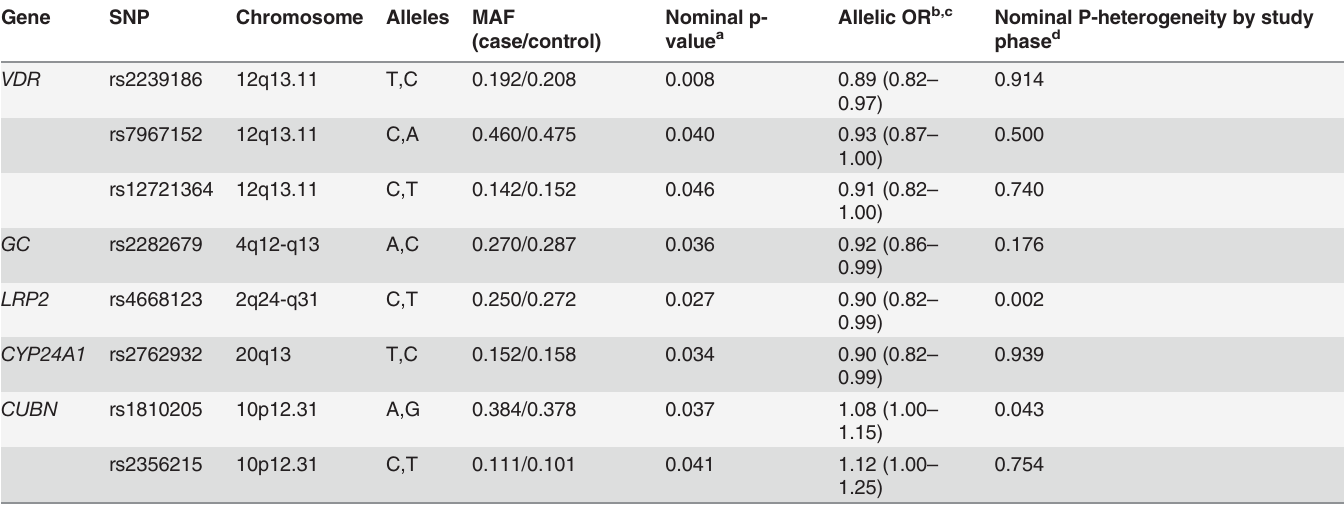
Table 2. Vitamin-D related single nucleotide polymorphisms (SNPs) with p-values < 0.05 and risk of pancreatic cancer from PanScan I-III (3,583 cases and 7,053 controls).